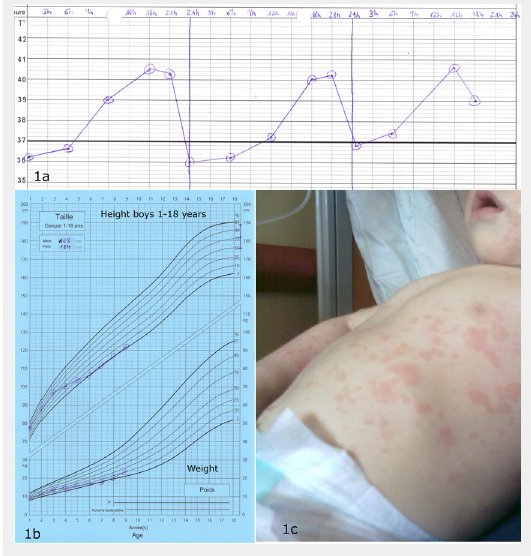
(1a) Typical temperature curve with one fever peak per day; (1b) short stature in a boy with SoJIA, beginning of disease at 2.5 years; (1c) rash in SoJIA.